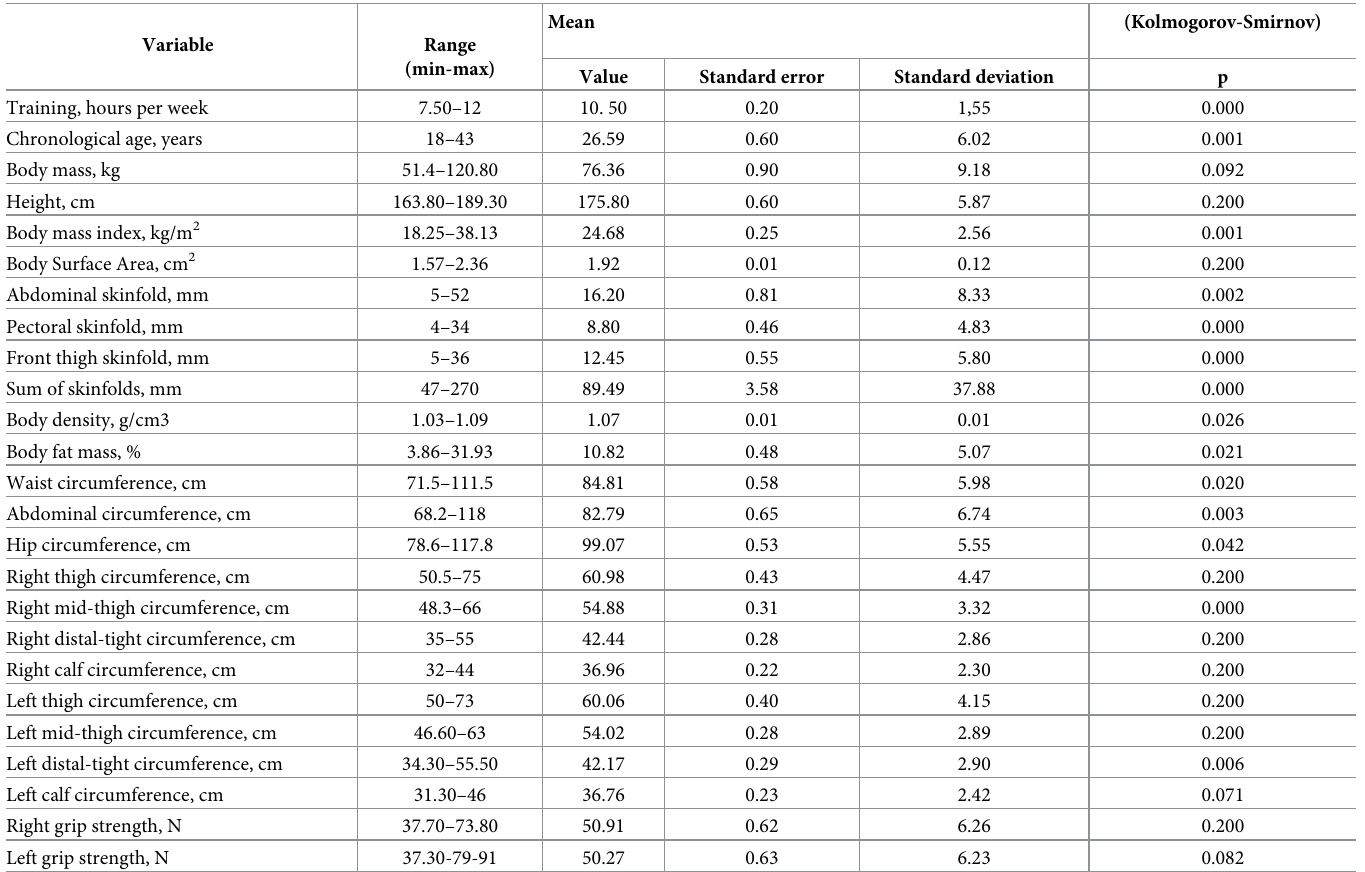
Table 1. Descriptive statistics combined for both ethnic